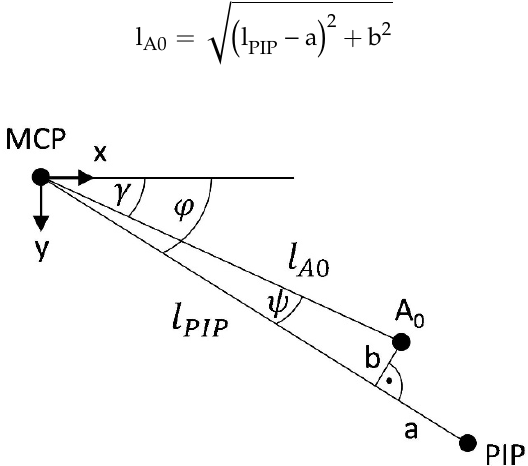
Figure 7. A scheme showing the displacement between A0 and PIP (proximal interphalangeal joint).